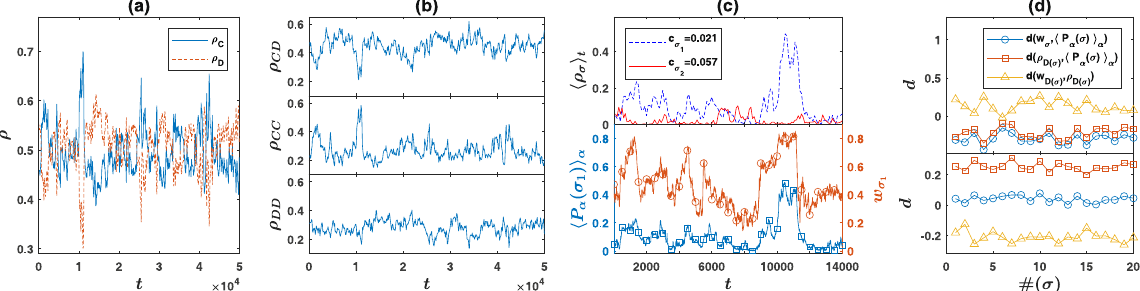
Figure 1. Evolution of partial cooperation and costly signaling. ( a ) Population average of the fraction of cooperation C and defection D in the strategy matrix of individuals as a function of time. A high level of cooperative strategies is maintained in the population. ( b ) Density of the strategy pairs played in the population, as a function of time. The partial cooperative CD strategy pair is the dominant strategy. ( c ) Up: Density of signals produced in the population, for two different signals with shown costs (numbered as signals 1 and 2). Down: Fitness σ w (red circles), and population average probability of production of signal σ 1 , 〈 P α ( σ 1 ) 〉 α (blue 1 squares). 〈 P α ( σ ) 〉 α follows the fitness of the signal, up to some fluctuations. ( d ) Direction of information flow from w σ to 〈 P α ( σ ) 〉 α (blue circles), from ρ D ( σ ) to 〈 P α ( σ ) 〉 α (red squares), and from the fitness of strategies which defect with signal σ , w D ( σ ) to their density ρ D ( σ ) (yellow triangles), for different signals numbered from 1 to n = 20. In the top panel ν σ = 0.01, ν s = 0.05, and in bottom ν σ = 0.5, ν s = 0.05. The variable with larger mutation rate becomes slave and the evolution of its density is derived by the